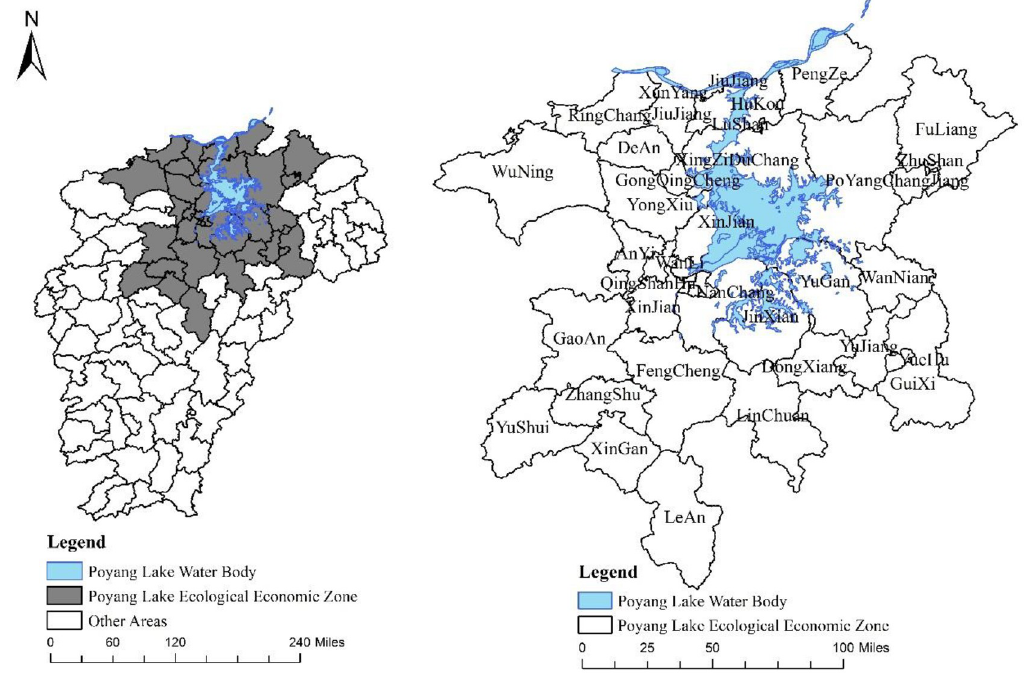
Fig 1. Geographical location diagram and administrative plan.